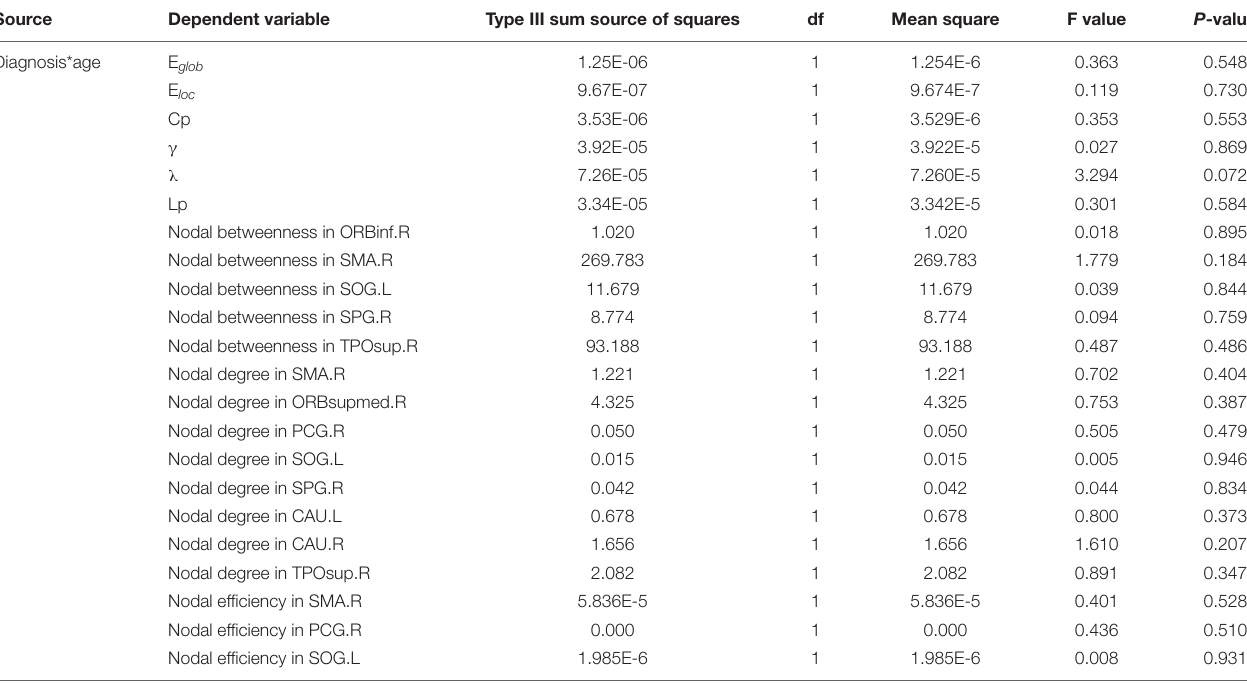
TABLE 3 | Linear modeling of age effects on node-level average controllability in drug-naïve patients with TS and HCs. Source Dependent variable Type III sum source of squares df Mean square F value P